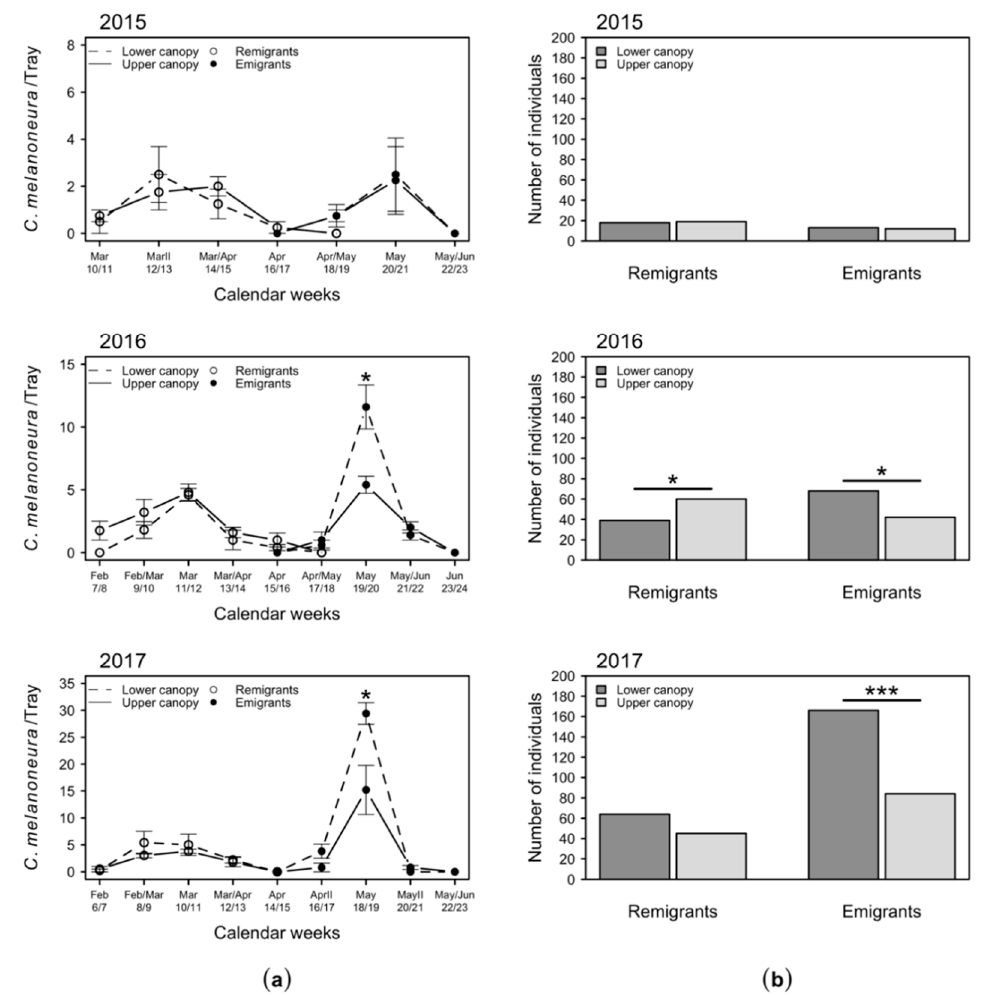
Figure 4. Numbers of C. melanoneura remigrant and emigrant specimens collected at the lower (1 m) and upper (2.5 m) canopy: ( a ) mean + SEM number of specimens collected in a bi-weekly routine per beating tray; ( b ) total catches per year. Significant differences between groups are indicated with * ( p < 0.05) and *** ( p < 0.001).